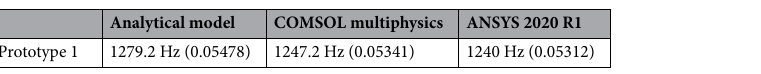
Table 1. Comparison of different FE